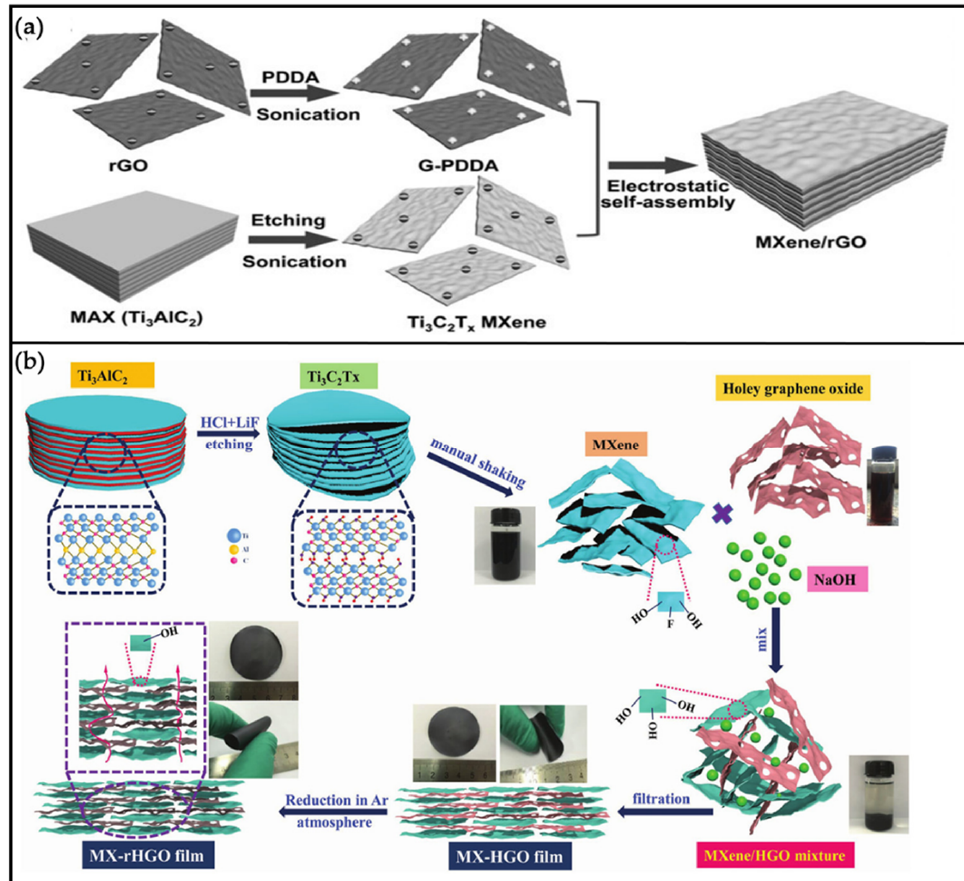
Figure 7. ( a ) Schematic illustration for the synthesis of the MXene/rGO hybrids. Reprinted with permission from Ref. [130]. Copyright 2017 WILEY-VCH Verlag GmbH & Co. KGaA. ( b ) Illustration of synthesis of the modified MXene/holey graphene film. Reprinted with permission from Ref. [128]. Copyright 2018 WILEY-VCH Verlag GmbH & Co. KGaA.